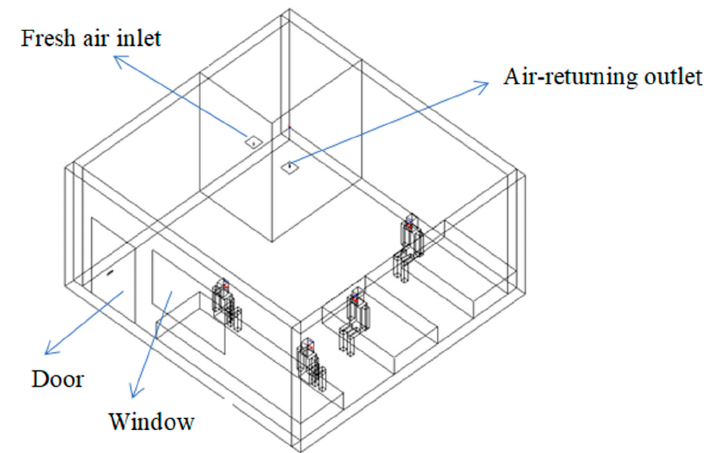
Figure 12. The arrangement of the mechanical ventilation.